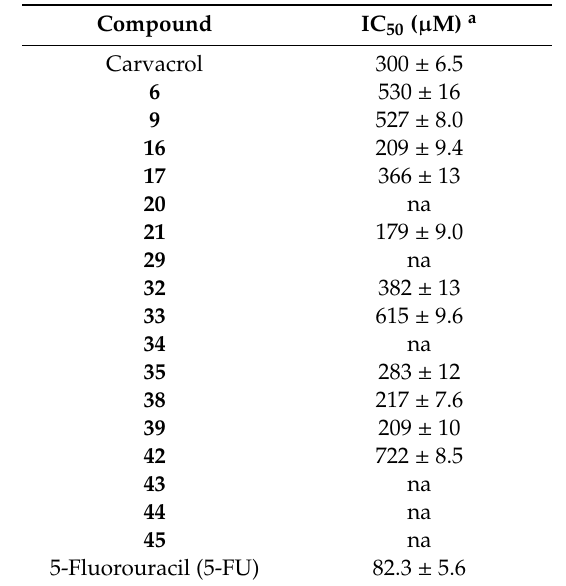
Table 2. IC 50 values are expressed as mean ± standard deviation (SD) of three experiments with quintuplicate